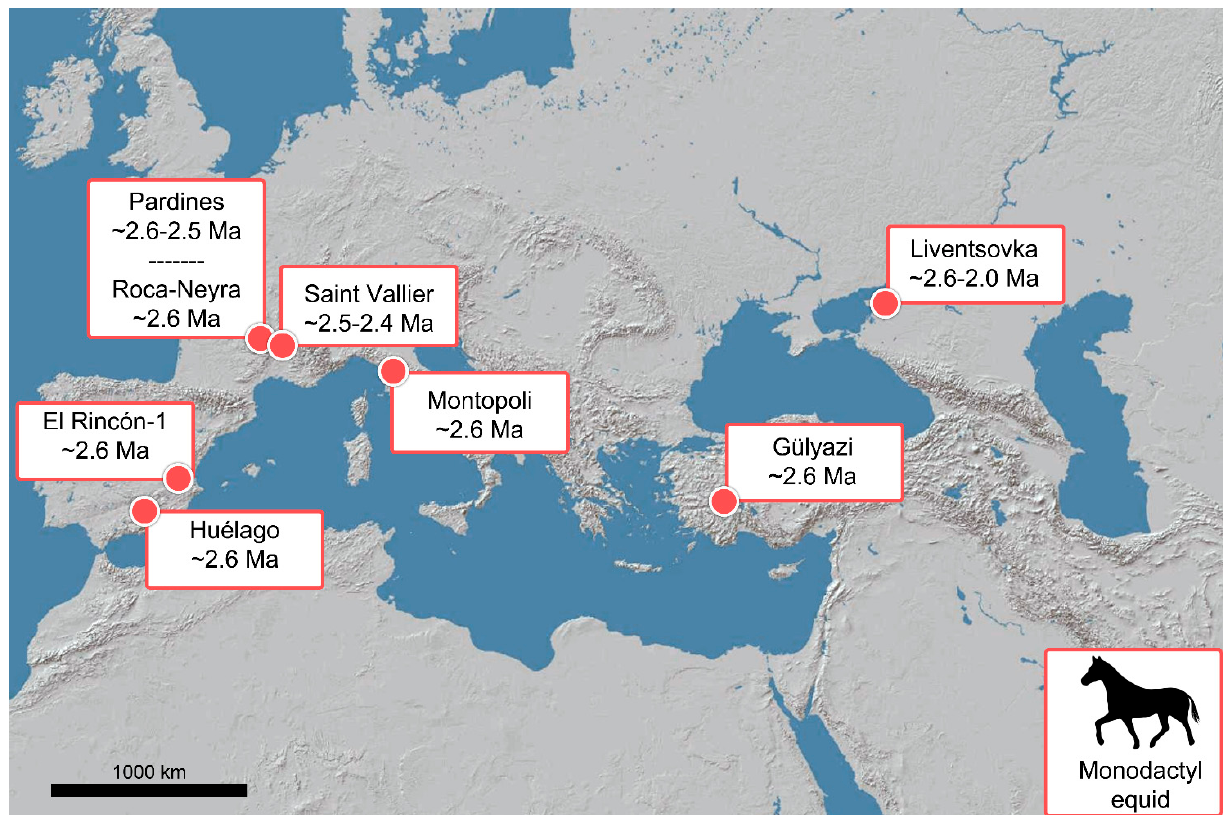
Figure 2. Selected localities mentioned in the text showing the occurrence of early monodactyl equid in western Eurasia.